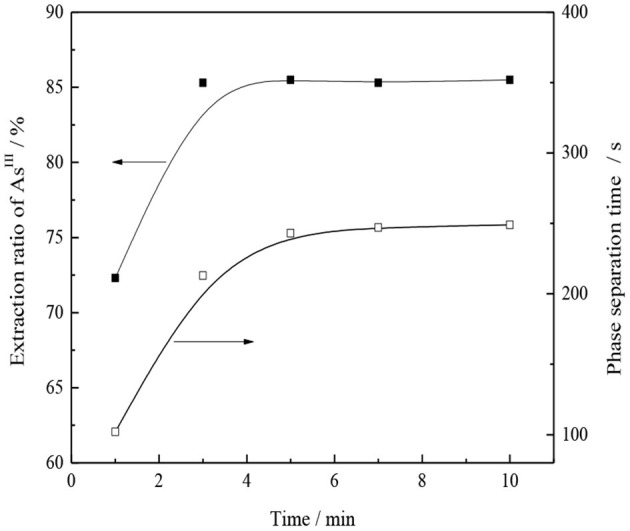
Effect of extraction time on AsIII extraction and phase separation.